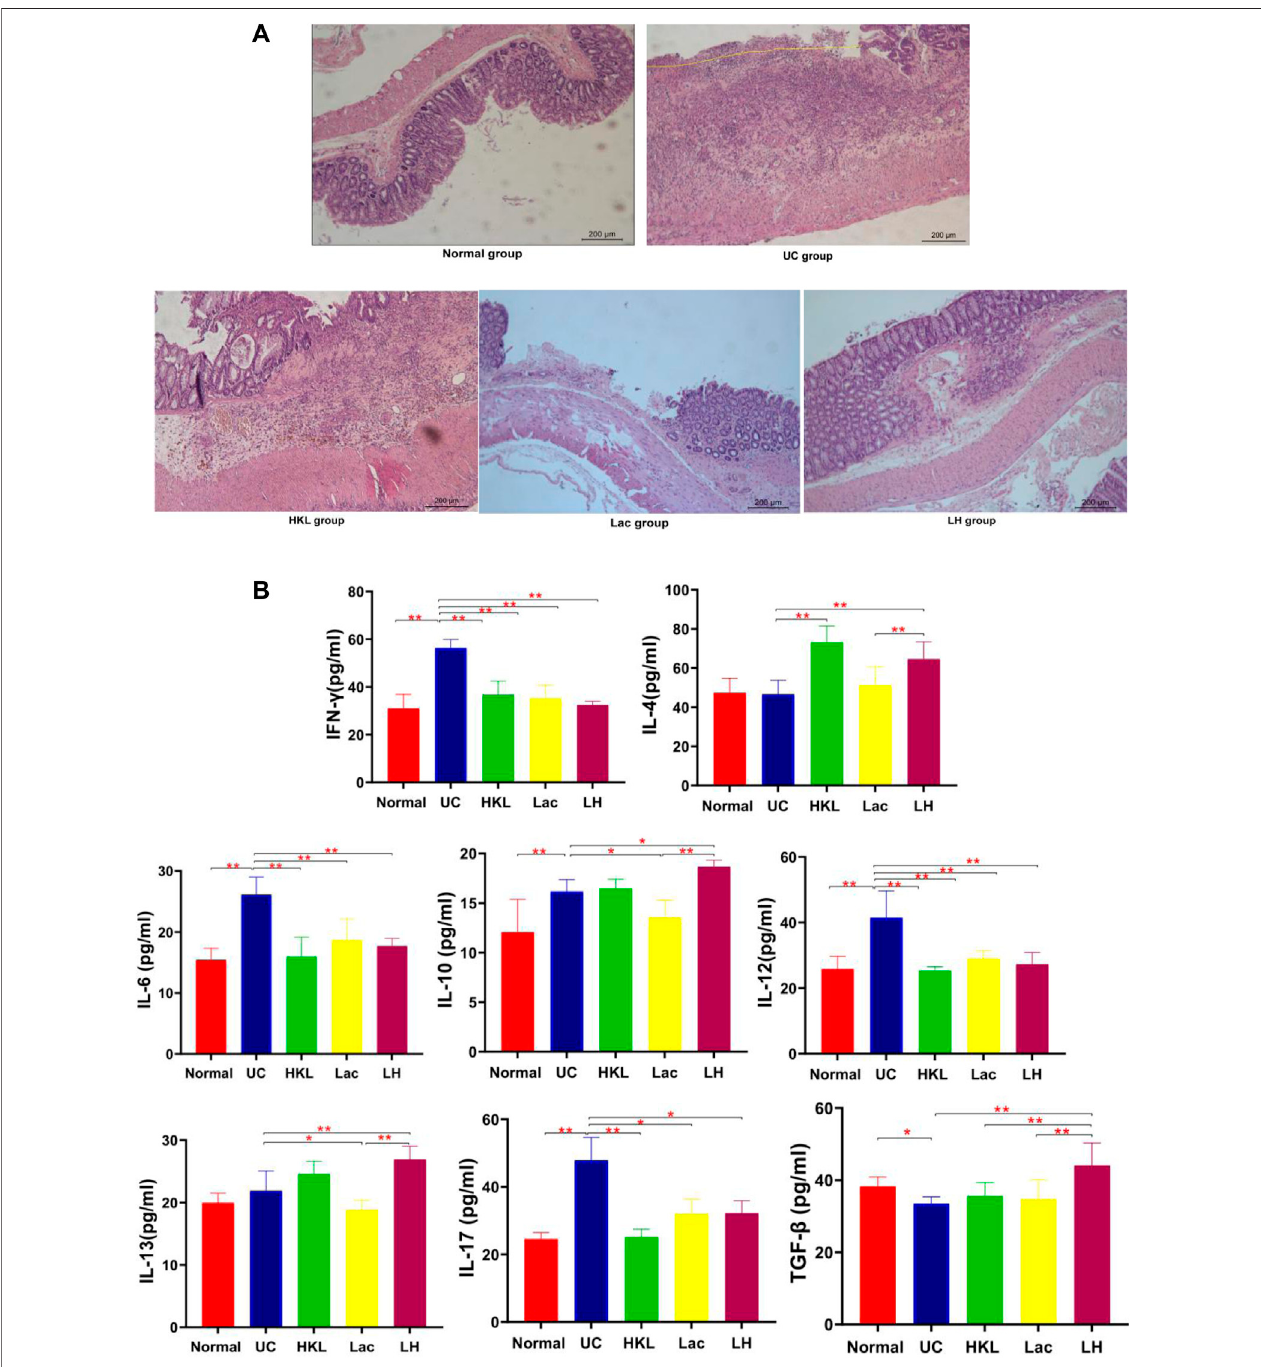
FIGURE 1 | LH treatment ameliorated in fl ammatory in fi ltration and histopathological injury in TNBS-treated rats. (A) Hematoxylin and eosin staining of colon tissue ( n = 8). (B) IFN- γ , IL-4, IL-6, IL-10, 1L-12, 1L-13, 1L-17, and TGF- β levels were determined by ELISA ( n = 6).** p < 0.01,* p < 0.05 vs. UC group.